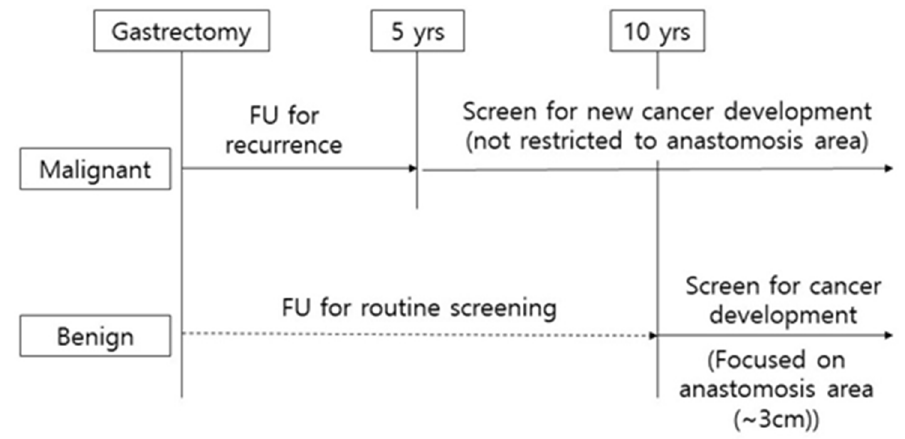
Figure 2. Scheme of clinical surveillance for remnant gastric cancer.